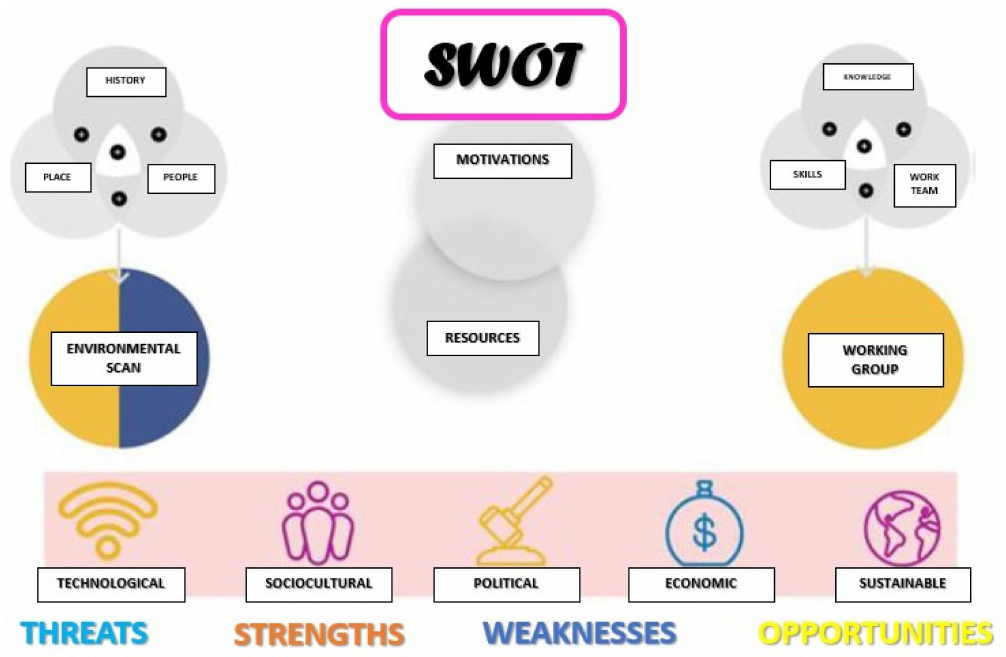
Figure 14. BOT according to SWOT. Source: own